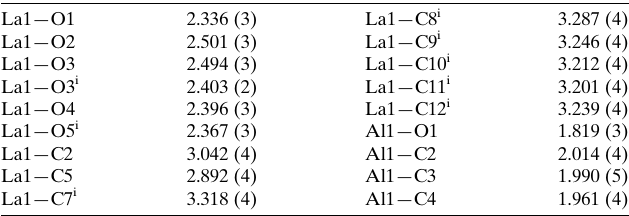
Table 1 Selected bond lengths (A˚